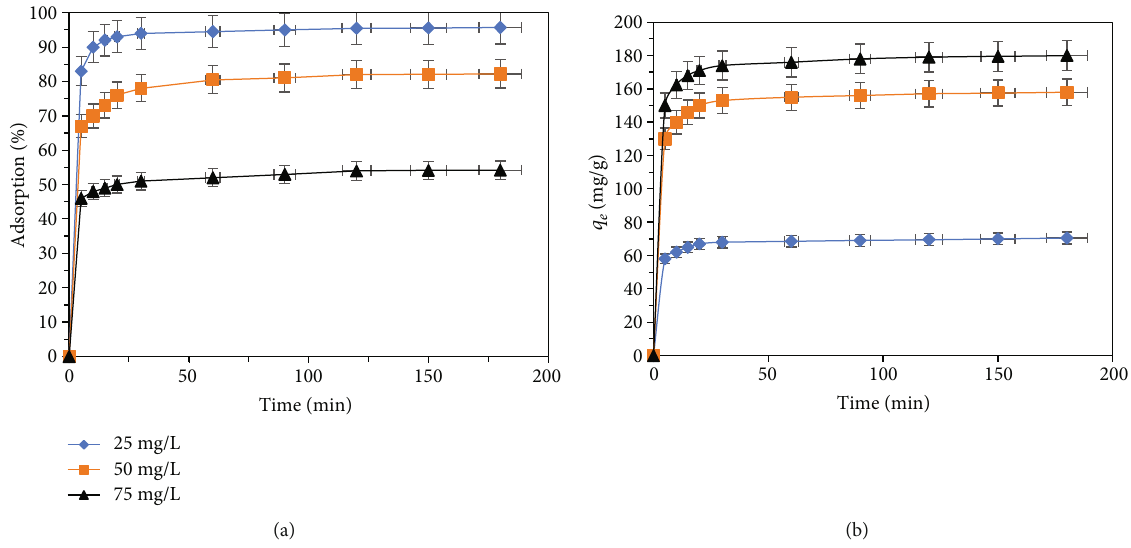
Figure 12: In fl uence of contact time for CV adsorption onto ACMAS (a) sorption rate and (b) sorption capacity, with ACMASdose = 0 : 15g/L and pH = 6 : 0 . Table 3: In fl uence of dye concentration on its own percentage